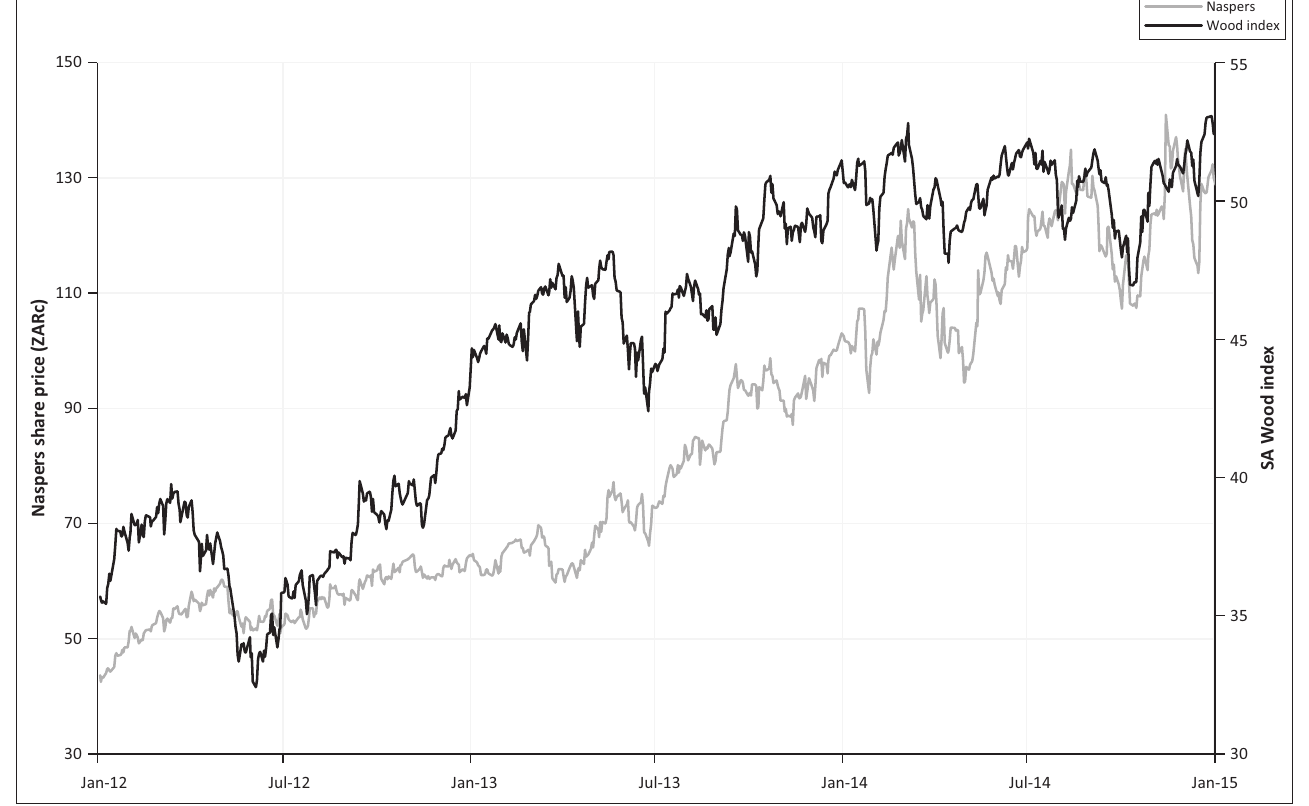
FIGURE 1-A1: Correlation example ( ρ = +0.92). TABLE 2-A1: Model error examples and loss impacts.